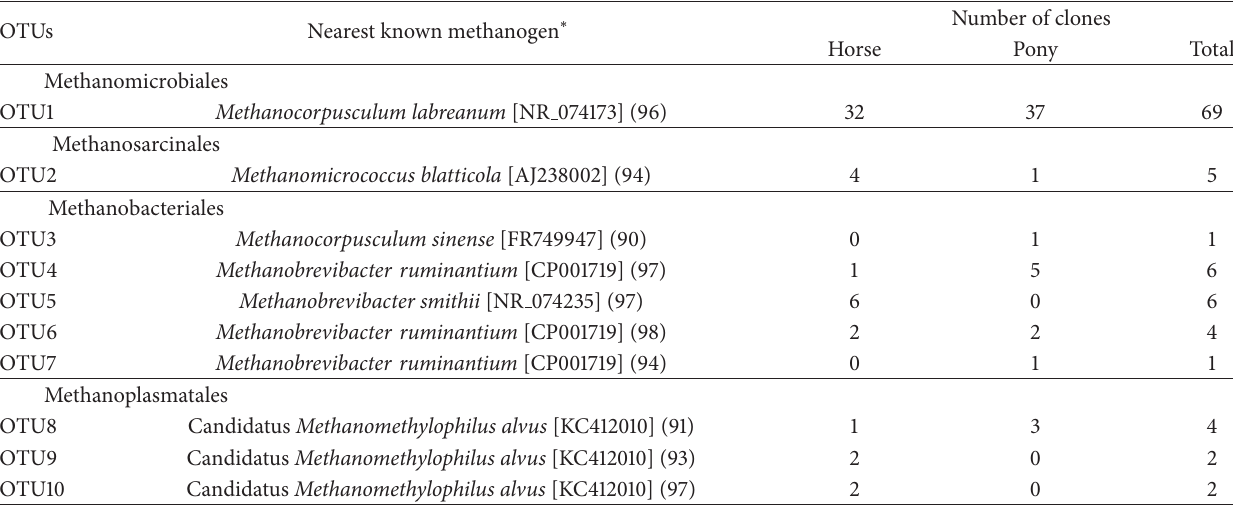
Table 4: The number of clones and similarity of the archaeal 16S rRNA gene sequences of each operational taxonomic unit (OTU) to cultured methanogens in horse and pony.